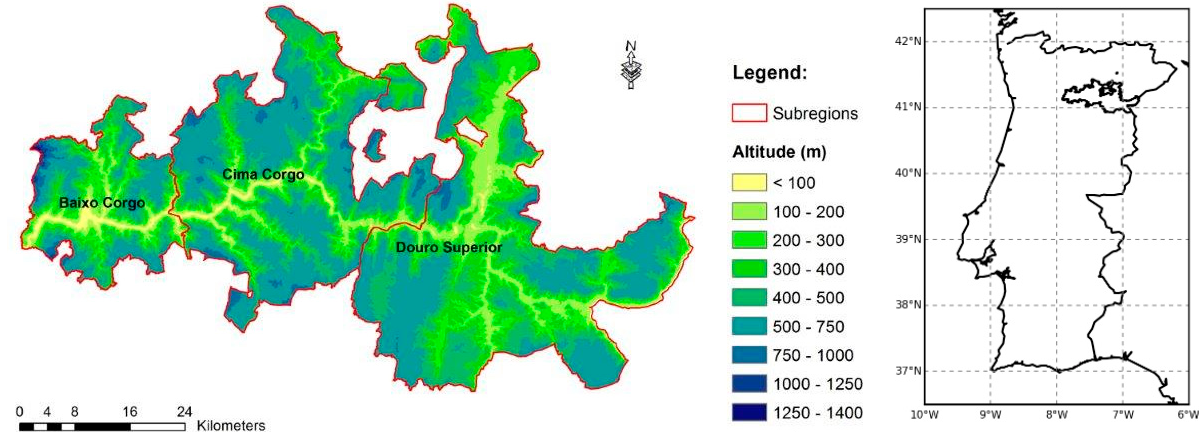
Figure 1. Case-study location, its sub-regions and topography.